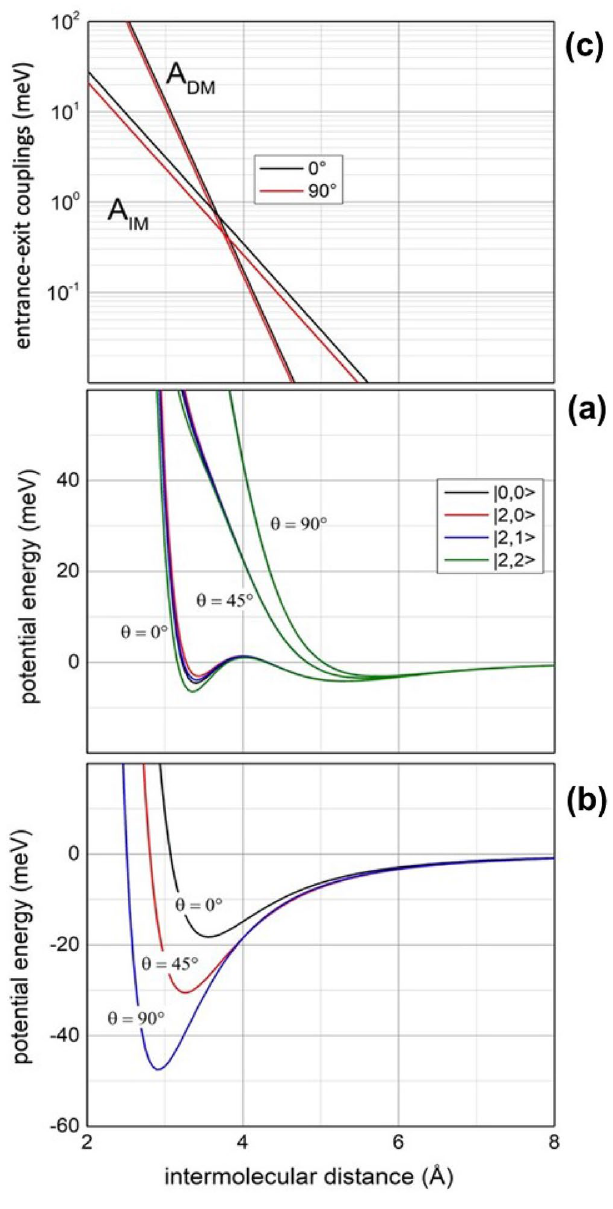
Figure 1. ( a ) Radial and angular dependence of the real part V t in each entrance channel. ( b ) The potential behaviour in the exit channel. ( c ) Radial and angular dependences of A DM and A IM couplings. The representation of the interaction potential for entrance and exit channels and details on the formulation of the various components is provided in (SI): it has been obtained extending that recently proposed for atom–atom reactions 15,16